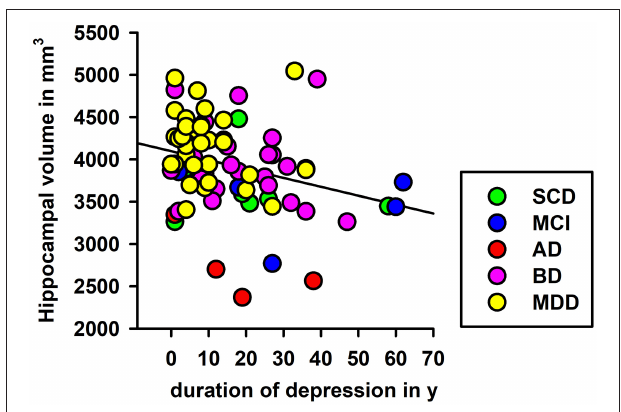
FIGURE 3 | Linear regression of depression duration and left hippocampal volumes. Significant regression analyses of depression duration and left hippocampal volume are shown. AD, Alzheimer’s disease; BD, bipolar disorder; L, left; aMCI, amnestic mild cognitive impairment; MDD, major depressive disorder; SCD, subjective cognitive decline; y,